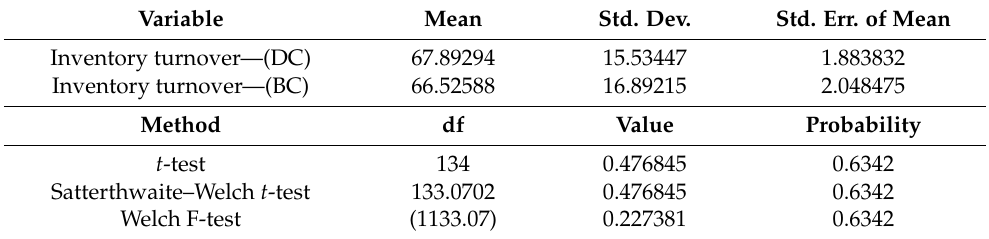
Table 9. The result of inventory turnover.